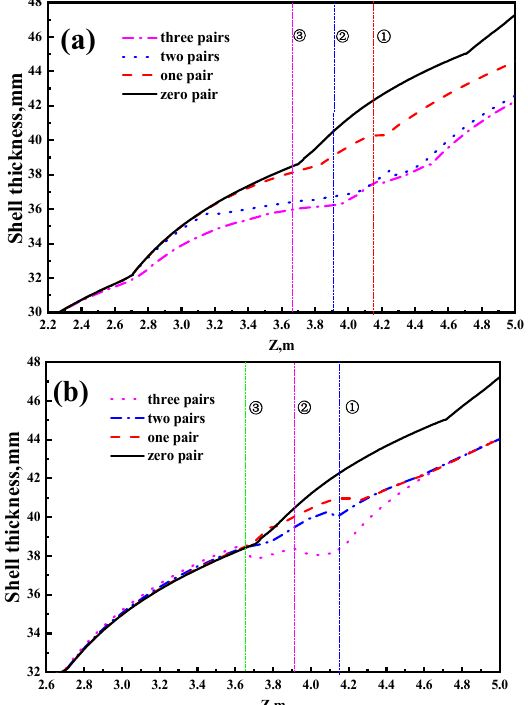
Figure 11. Distribution of the shell thickness at the narrow center face of the strand on the ( a ) start side and ( b ) thrust